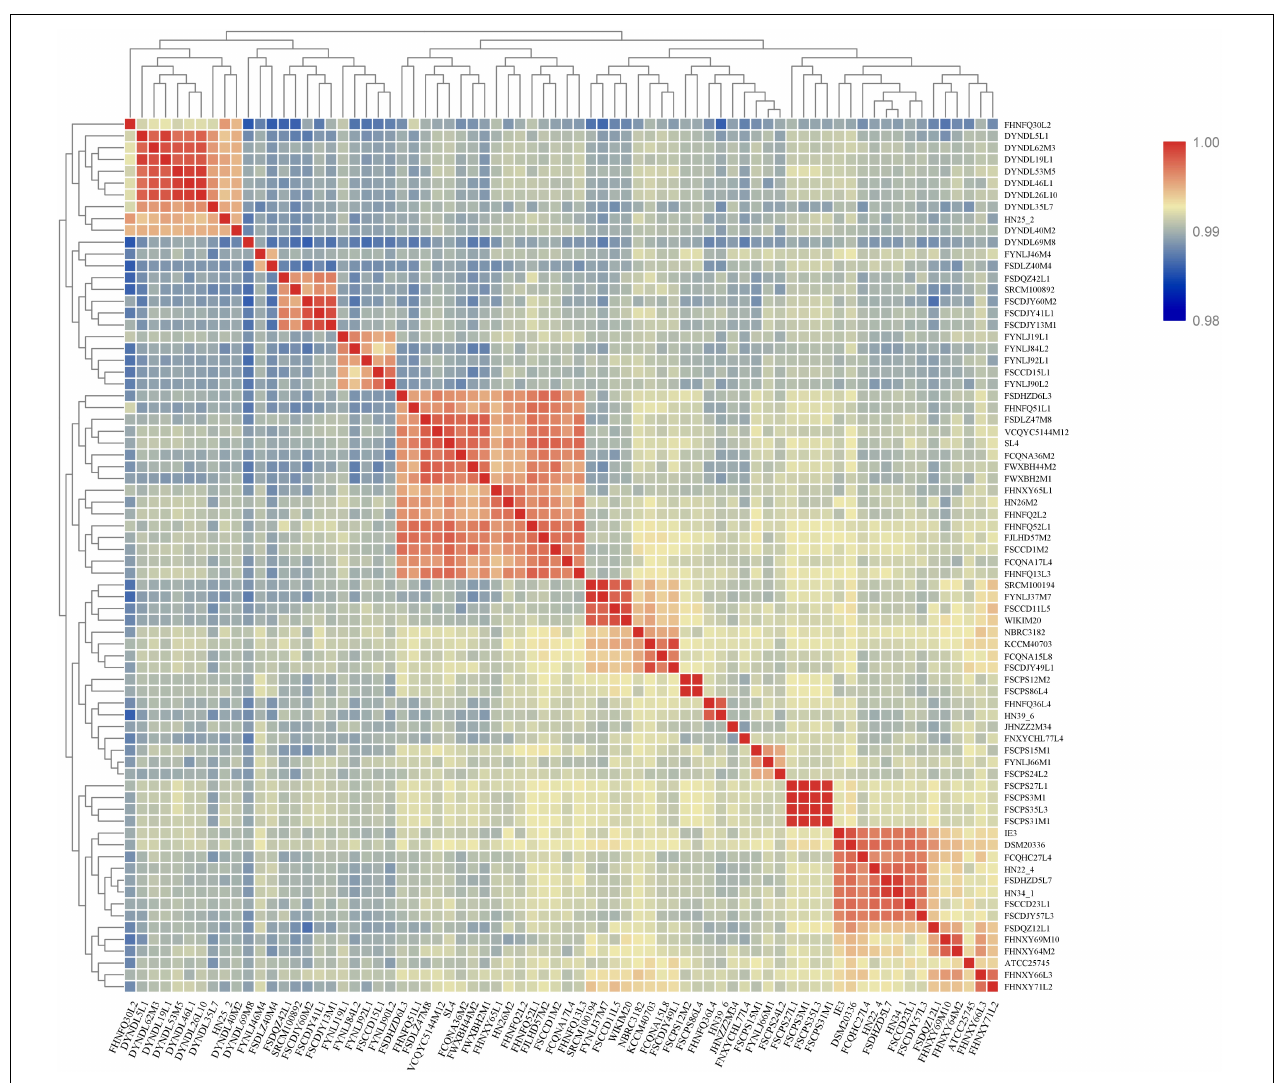
FIGURE 4 | Heatmap showing ANI of P. pentosaceus strains. Proposed species cut-off boundary is around 95–96%, showing identity within theses